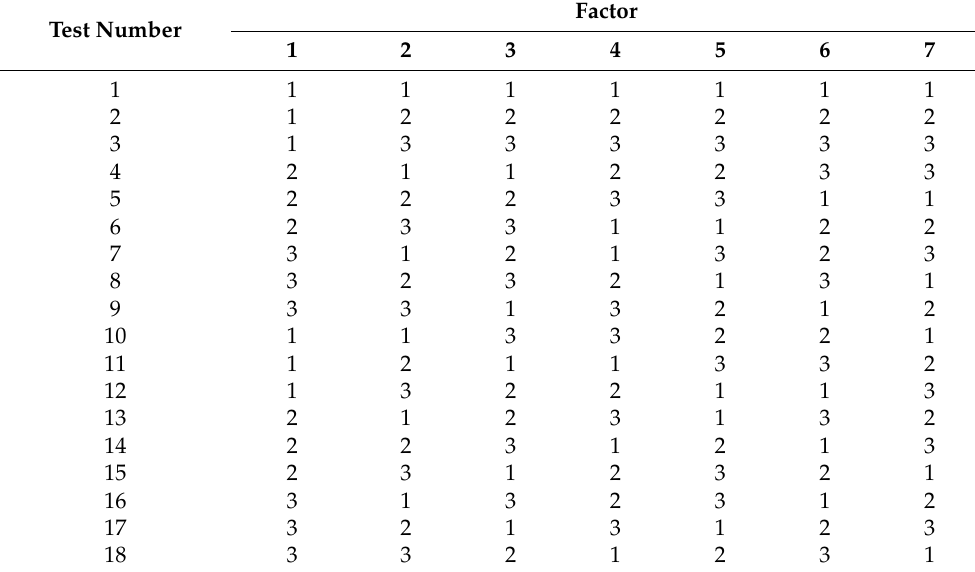
Table 4. The 7-factor, 3-level orthogonal table.